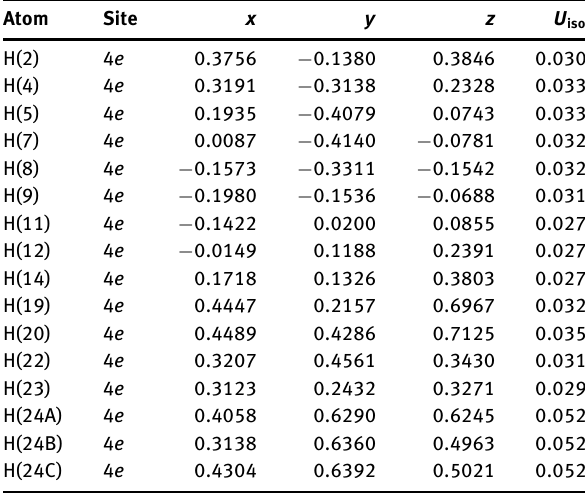
Table 2: Fractional atomic coordinates and isotropic or equivalent isotropic displacement parameters (Å 2